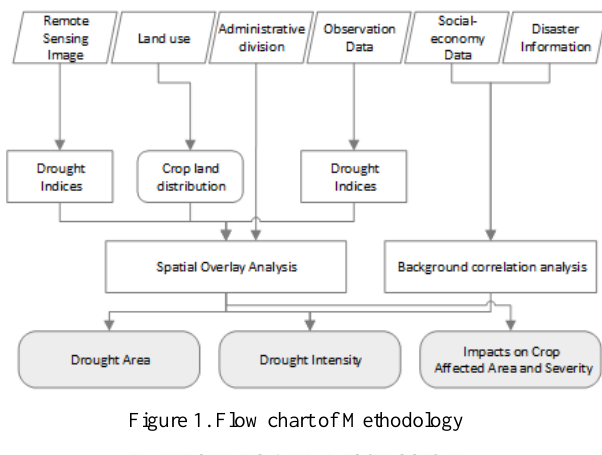
Figure 2. A Typical Drought Event